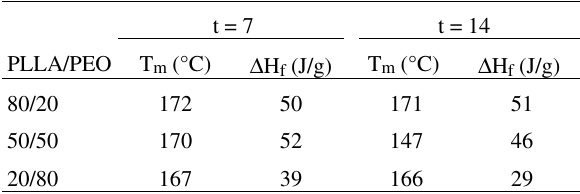
Table 5. Melting temperature and fusion enthalpy variation values (for run 2) for PLLA/PEO blends which were immersed in the buffer for 7 or 14